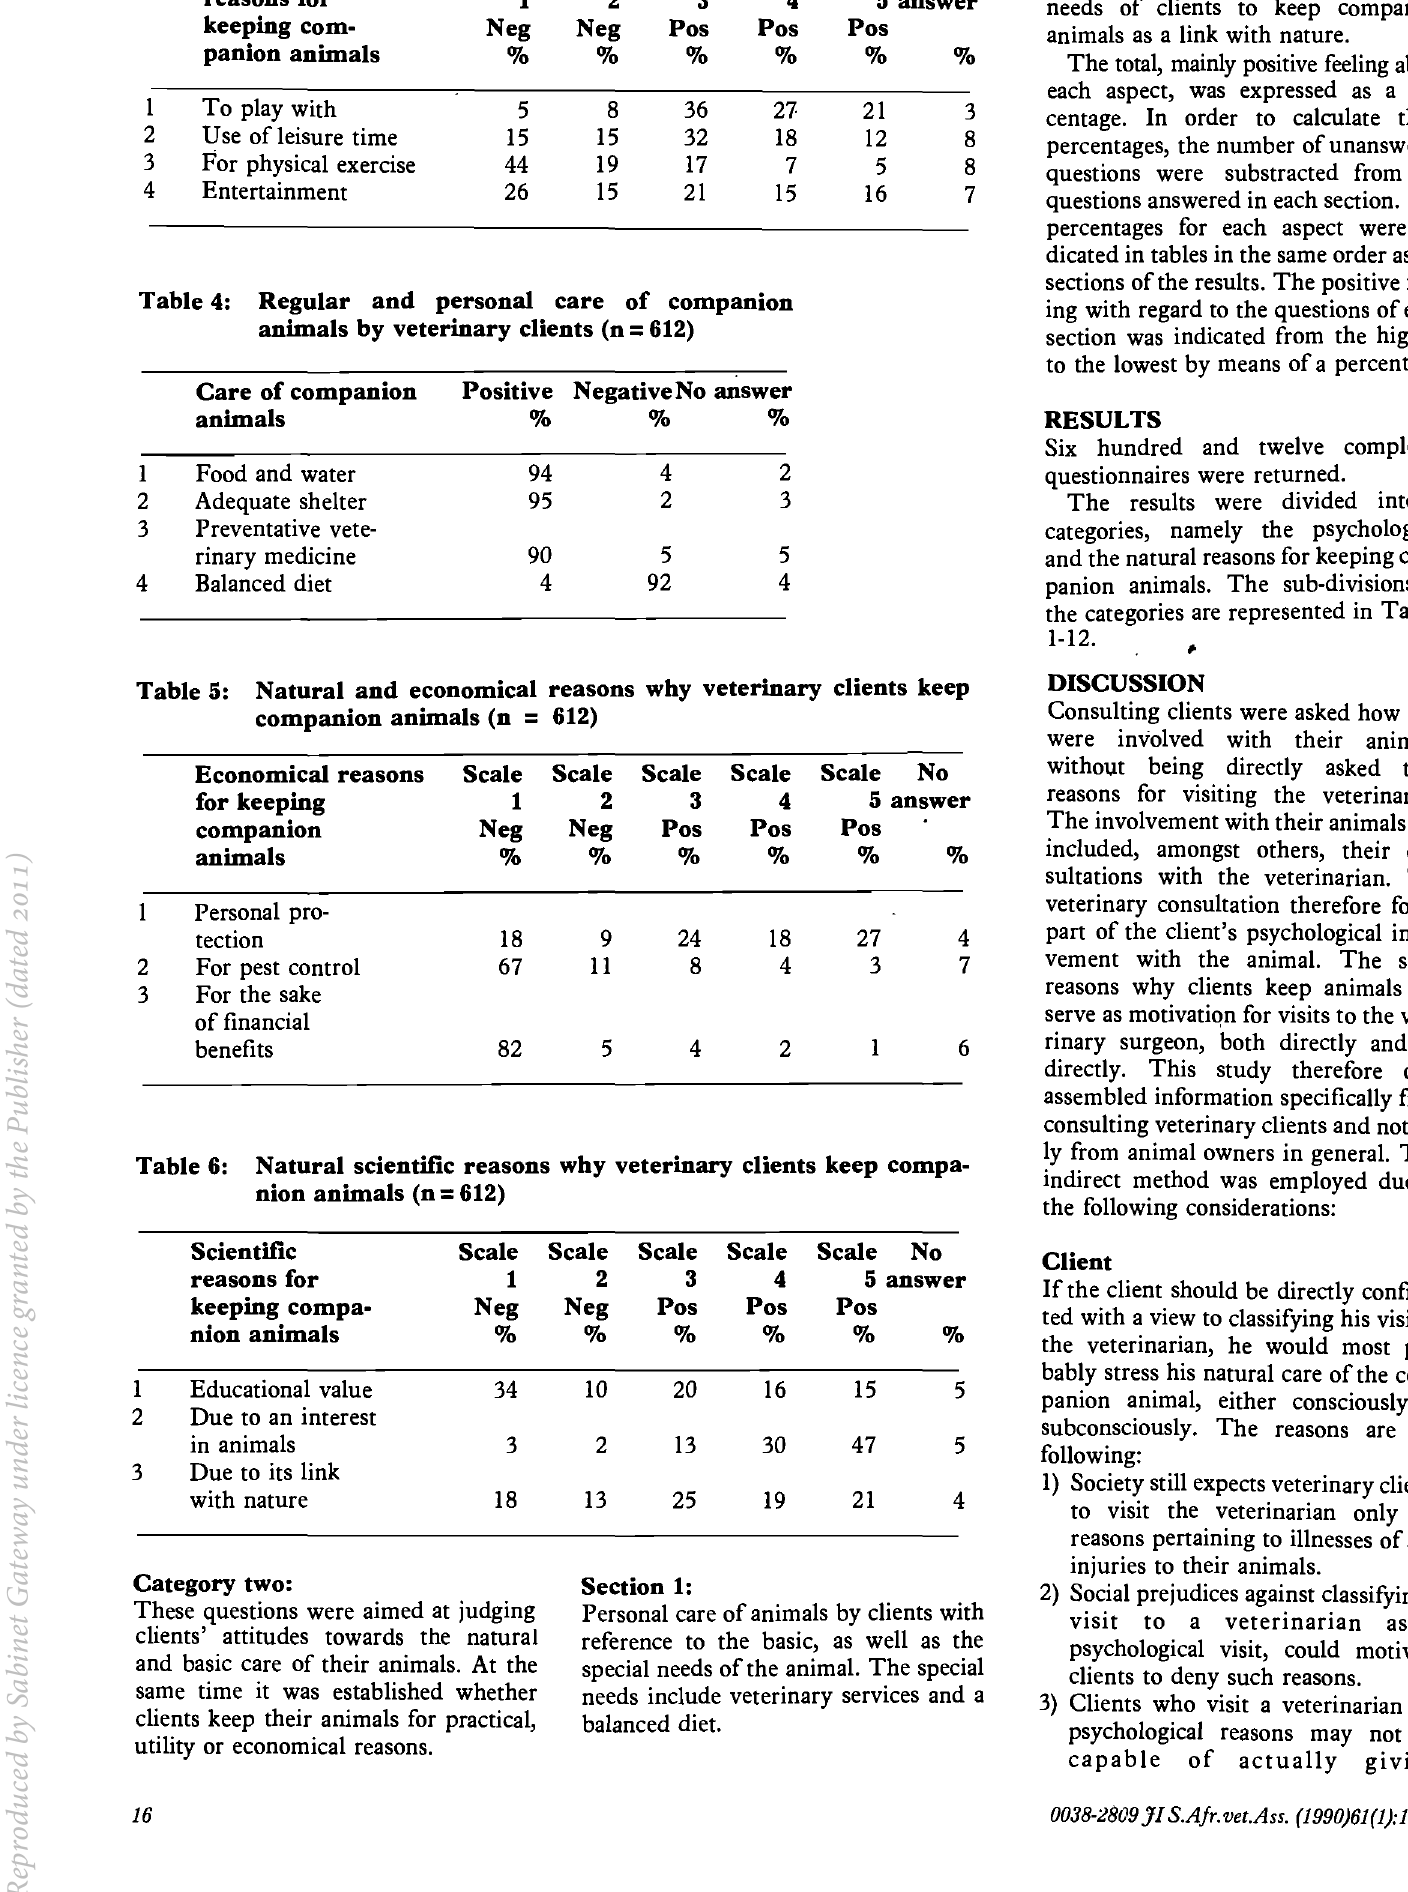
Table 3: "Relaxatio':"al reasons for keeping companion animals (n Relaxational